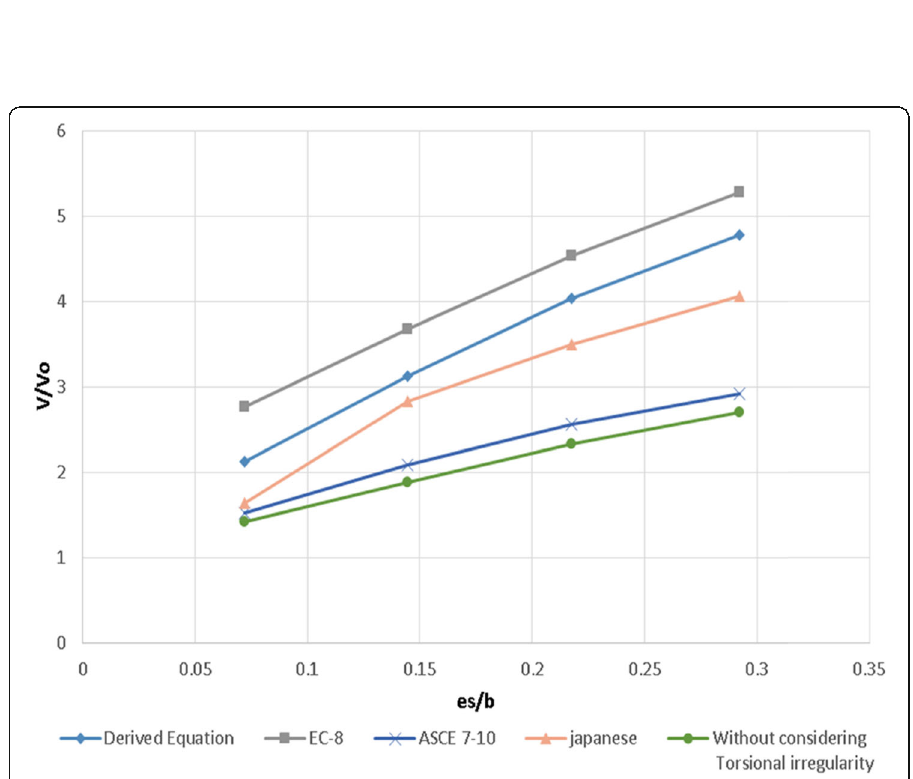
Fig. 47 Comparison of eccentricity ratio — design force ratio (design force in un-symmetric model V o , normalized by design force in symmetric plan V ) for flexible side elements for ASCE 7-10, EC-8, Japanese, derived equation, and without considering Torsional